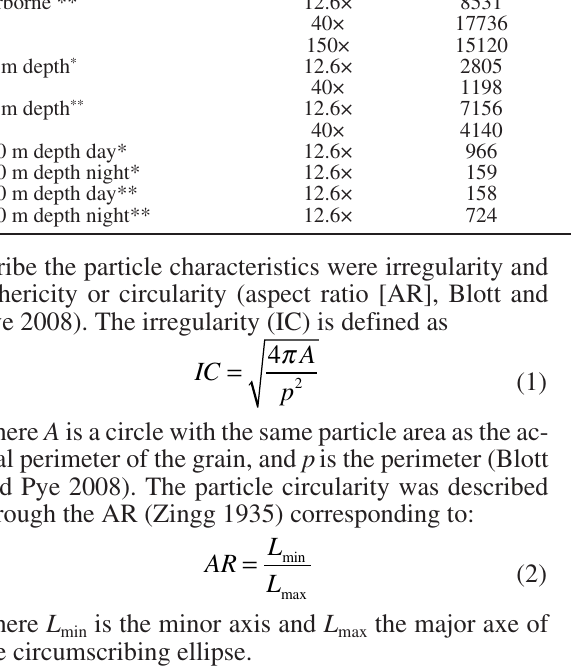
Fig. 4. – Image treatment process. The morphometric characteristics area, perimeter, length of major and minor axis, and number of pixels were measured in the vectorized images. Table 2. – Grain-size parameters of samples determined by optical and electronic microscopy. * non-dust event; ** dust event. Sample Zoom Particles analysed Mean size (μm) Sorting Skewness Kurtosis Airborne * 500×